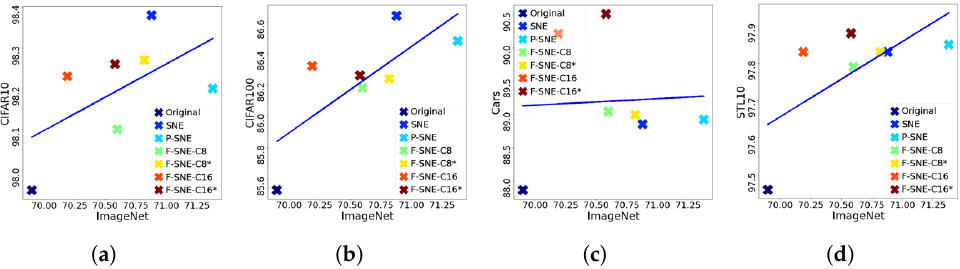
Figure 5. Correlation between pre-training and transfer learning performances is plotted. S models are used. ‘X’ markers denote the accuracies of each model, and the blue line denotes the regression slope of the results. In contrast to other correlated plots, the results on the Stanford Cars dataset are not correlated with the results on the ImageNet dataset. Best viewed in color. ( a ) IMNet-C10. ( b ) IMNet-C100. ( c ) IMNet-Cars. ( d )